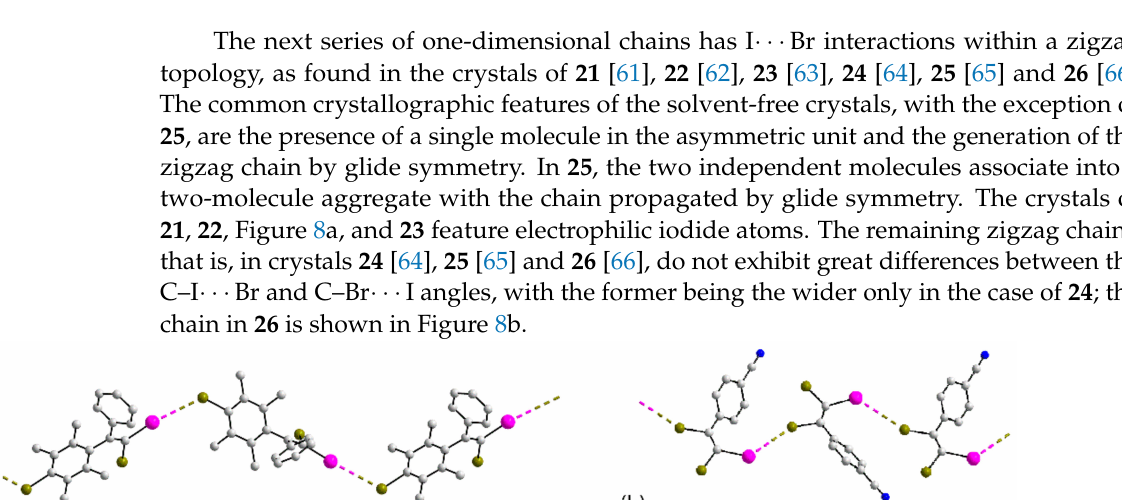
Figure 8. One-dimensional, zigzag chains in the crystals of ( a ) 22 and ( b ) 26 . Comprising the largest subset of one-dimensional assembles, the are 13 crystals featuring helical chains, namely 27 [66], 28 [67], 29 - 31 [68], 32 [69], 33 [70], 34 [71], 35 [72], 36 , 37 [73], 38 [74] and 39 [68]. A high degree of homogeneity again exists among the solvent-free crystals with all helical chains being propagated by 2 1 screw symmetry. All but one crystal comprises a single molecule in the asymmetric unit. The exceptional crystal is 32 , where only one of the two independent molecules comprising the asymmetric